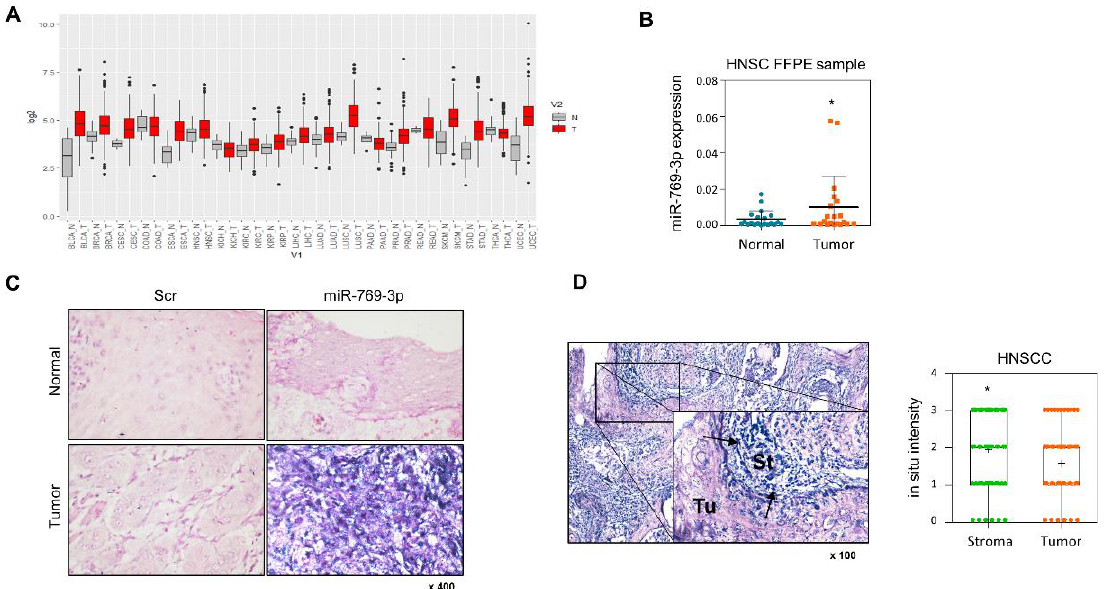
Figure 1. Expression pattern of miR-769-3p expression in head and neck squamous cell carcinoma (HNSCC). ( A ) The expression level of miR-769-3p in normal (gray) and tumor (red) tissues from the GENT2 data set; ( B ) qRT-PCR of miR-769-3p in tumor and normal FFPE samples from head and neck squamous cell carcinoma patients (HNSCC, n = 20); ( C ) in situ hybridization for miR-769-3p in tissue microarrays of HNSCC patients; and ( D ) localization of miR-769-3p expression in HNSCC and normal adjacent tissues using in situ hybridization. miR-769-3p was highly expressed predom- inantly in fibroblast-like cells (arrow) within the stroma (St) but not in the intra-tumoral lesion (Tu). Data represent mean ± SD. P value was determined using two- tailed Student’s t -test. * p ≤ 0.05. 3.2. RNA Sequencing Reveals a Tumor-Suppressive Role of miR-769-3p by Modulating Stromal Gene Expression We evaluated the expression levels of miR-769-3p in three different OSCC lines, of which miR-769-3p expression in CAL27 cells was the lowest (Figure 2A). To analyze the change in the transcriptome profile influenced by miR-769-3p expression, after the trans- fection of miR-769-3p in CAL27 cells (Figure 2B), we performed RNA-sequencing analysis using three different batches of miR-769-3p-transfected CAL27 cells. Figure 2C shows the significantly upregulated (n = 2694) and downregulated genes (n = 2312; fold-change ≥ 2 and p ≤ 0.05) in miR-769-3p-transfected cells. To gain insight into the biological functions of miR-769-3p, we performed an Ingenuity Pathway Analysis (IPA) (Figure 2D). The ca- nonical mTOR signaling pathway was most significantly enriched in miR-769-3p ( p = 5.70 × 10 −4 ). To further analyze the signalling pathways involved in the development of the molecular phenotypes affected by miR-769-3p, we performed GSEA and identified en- riched gene signatures in the RNA-sequencing profiles. Gene signatures including inter- feron-gamma-related genes (normalized enrichment score, NES = 2.45) were enriched, whereas MYC target gene signatures (NES = − 4.82) were depleted in miR-769-3p-overex- pressing cells (Figure 2E). qRT-PCR analyses also confirmed that immune-related genes were upregulated, whereas MYC-related genes were downregulated in miR-769-3p-over- expressing cells (Figure 2F). These findings suggest that miR-769-3p acts as a modulator of stromal gene expression.